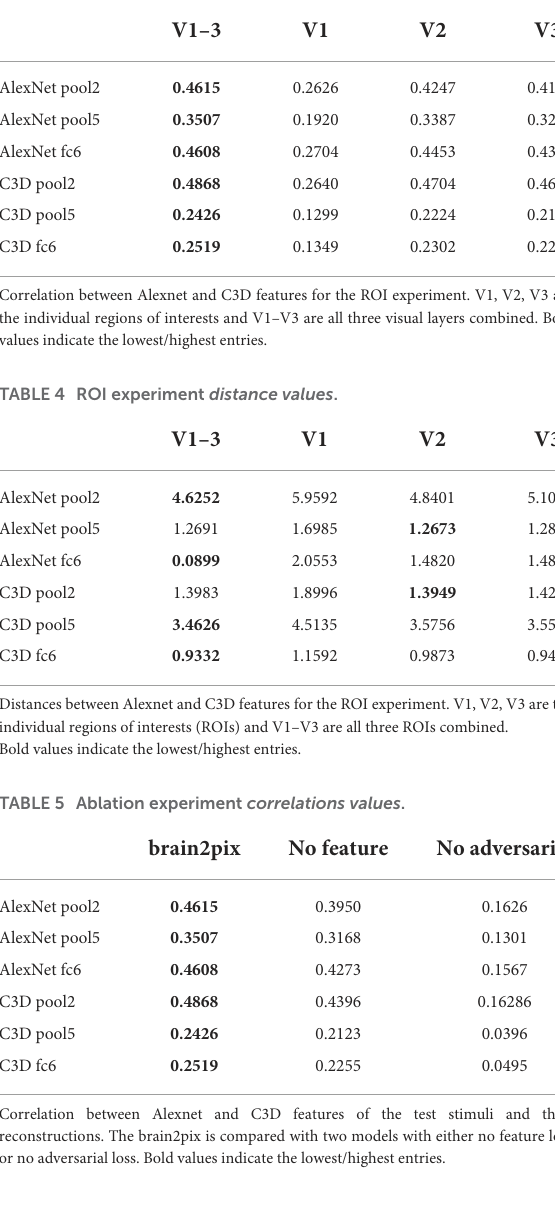
TABLE 3 ROI experiment correlation values .